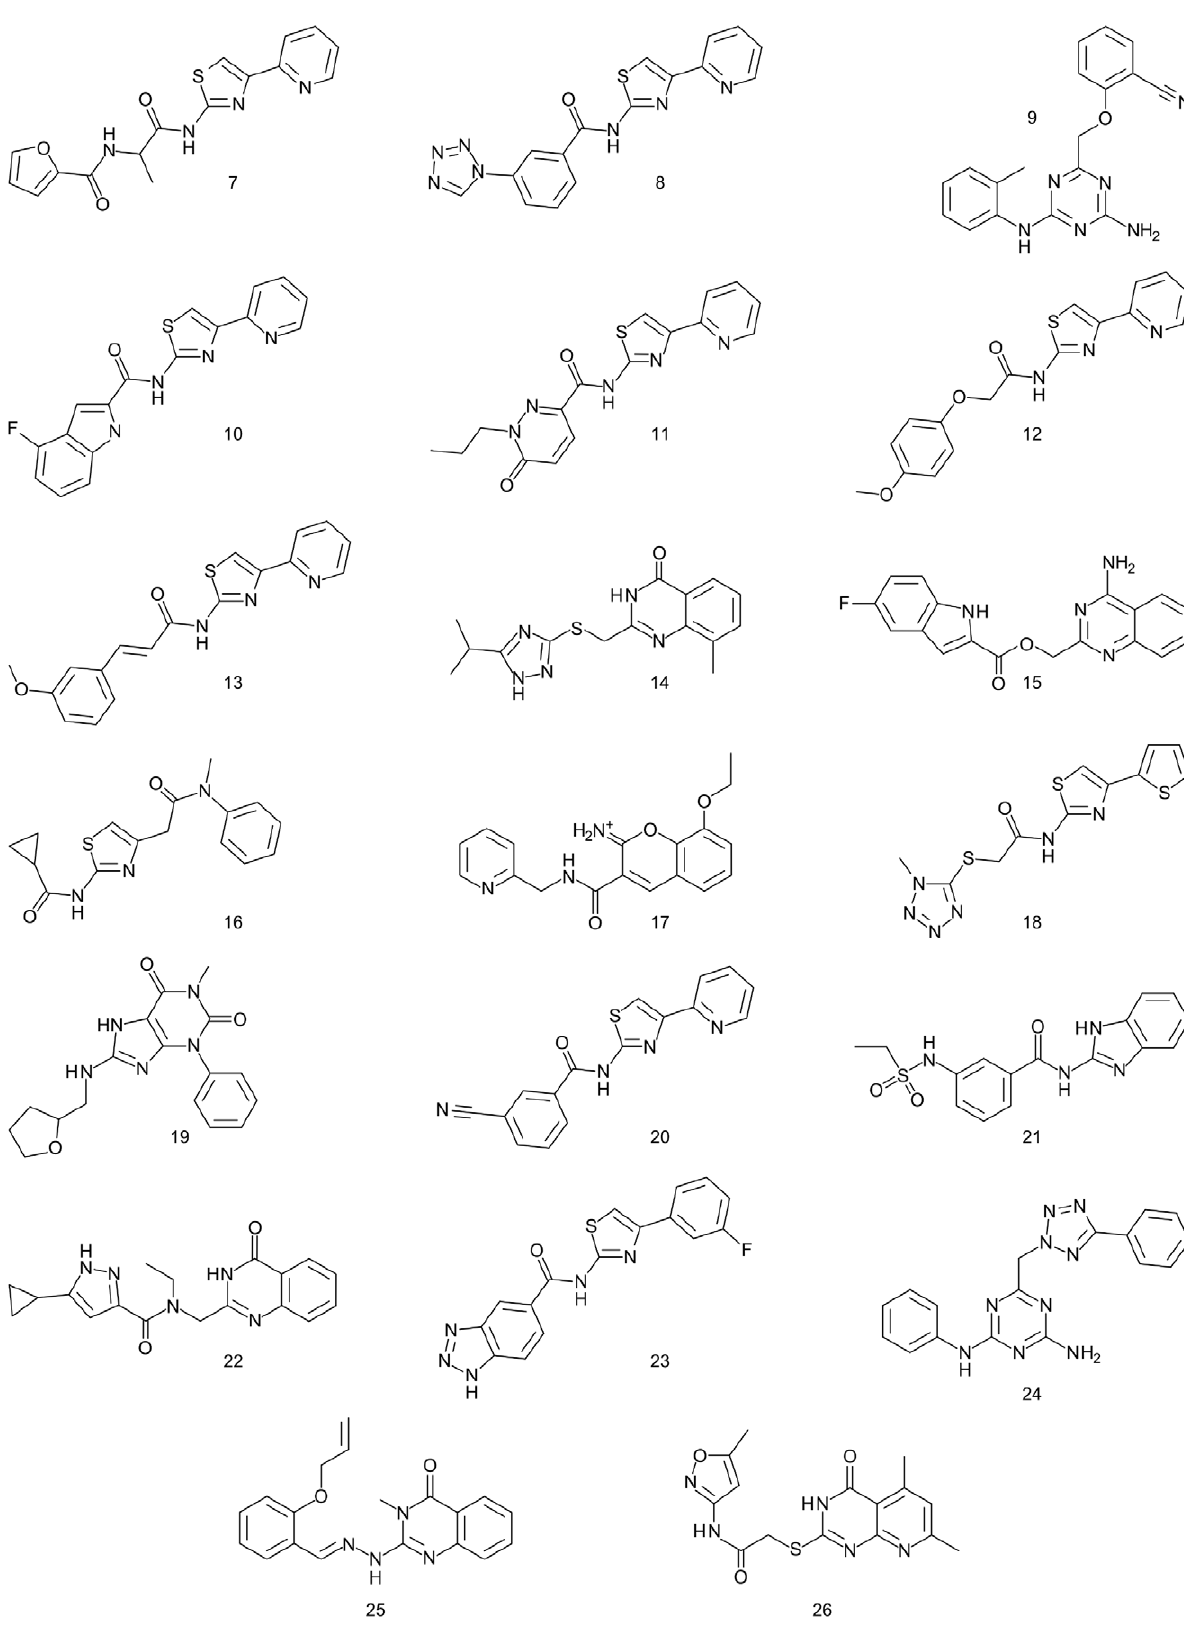
Figure 5. Chart 2. Molecules identified in this study. Binding affinity data at three AR subtypes are presented in Table 1.